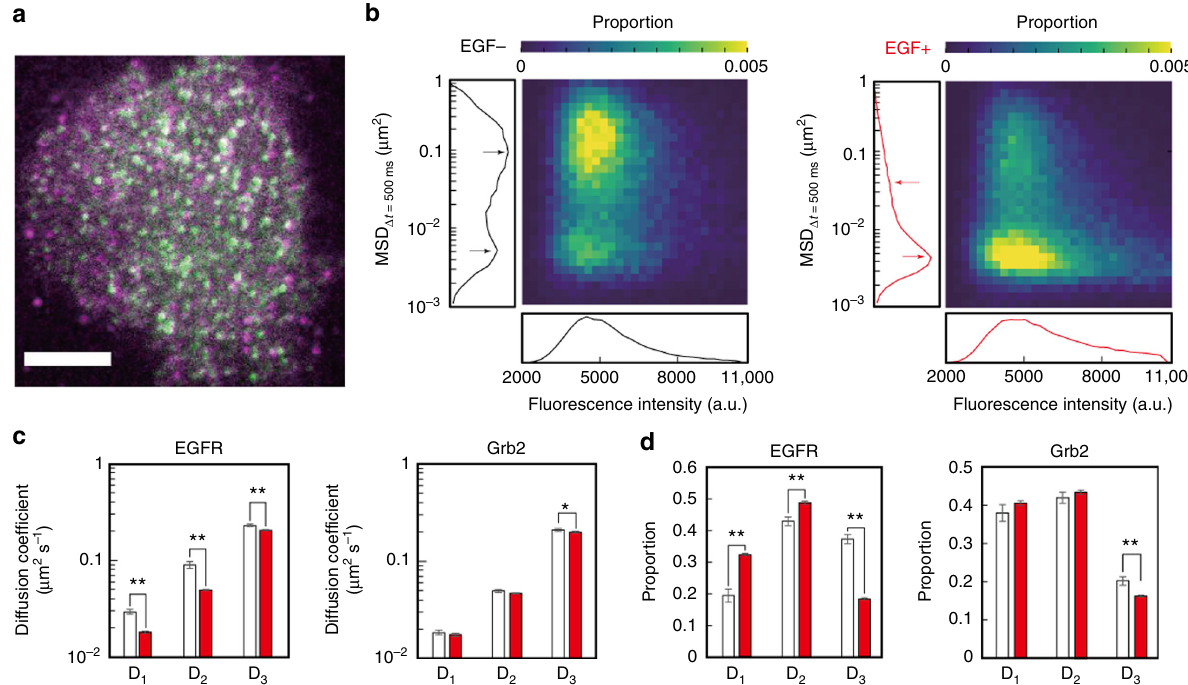
Fig. 4 Two-color automated single-molecule imaging. a Merged image of EGFR-GFP (green) and Grb2-TMR (magenta) at the basal cell surface. Magenta spots shown outside the cell are free TMR molecules absorbed on the coverslip. Scale bar: 5 μ m. b Heat maps of the MSD at 500 ms and fl uorescence intensities before (left) and after (right) 60 nM EGF stimulation. Panels on the left and bottom of each heat map show histograms of the MSD at 500 ms and fl uorescence intensities, respectively. Arrows indicate the peaks of subpopulations corresponding to the EGFR states. The number of observed cells before and after EGF addition was 148 and 146, respectively. c , d Averaged diffusion coef fi cients ( c ) and fractions ( d ) of three EGFR (left) and Grb2 (right) motional states before (white) and after the addition of EGF (red). Asterisks indicate signi fi cant differences (* P < 0.05, ** P < 0.01). The number of cells before and after the addition of EGF was 4 and 22 in the EGFR observation and 44 and 20 in the Grb2 observation, respectively. Error bars: